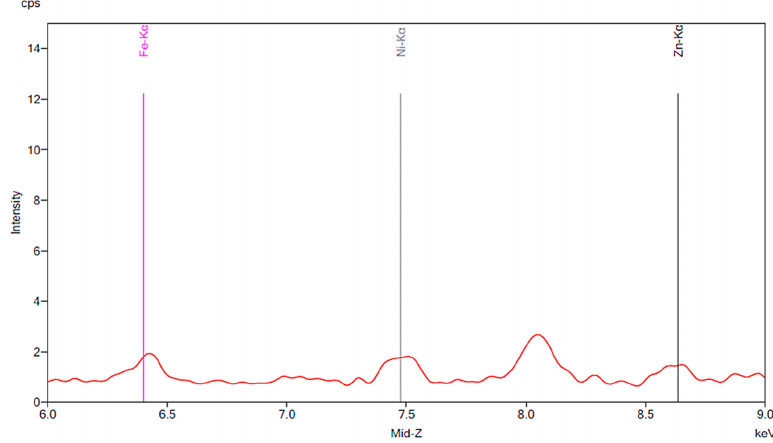
Figure 13. Baseline spectrum for a sample of chlorhexidine. The parameters are the same as those used for the other baseline spectra described in this paper.